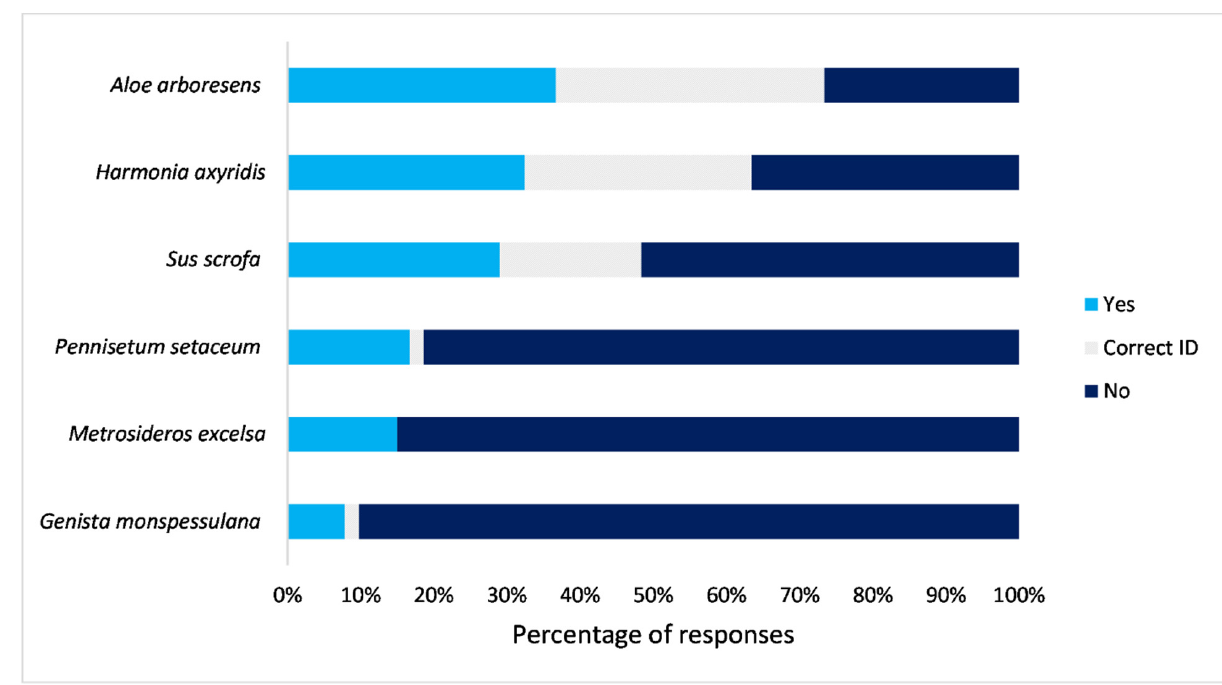
Figure 4. Percentage of questionnaire participants that could recognise the target species (Aloe arborescens, Genista monspessulana, Harmonia axyridis, Metrosideros excelsa , Pennisetum setaceum, and Sus scrofa ). Light blue indicates respondents said that they could recognise the species but could not name it; grey indicates respondents that could recognise and correctly name/identify the species, and dark blue indicates those that did not recognise the species. Aloe arborescens is indigenous to South Africa, and the rest of the species are invasive.